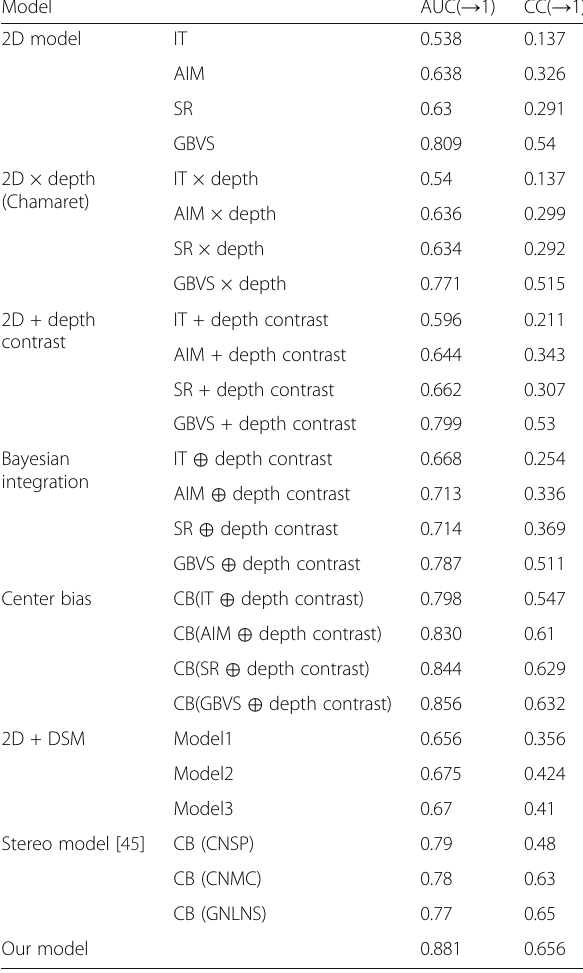
Table 3 Comparison between the proposed framework with the others. DSM represents the depth saliency map in [17]